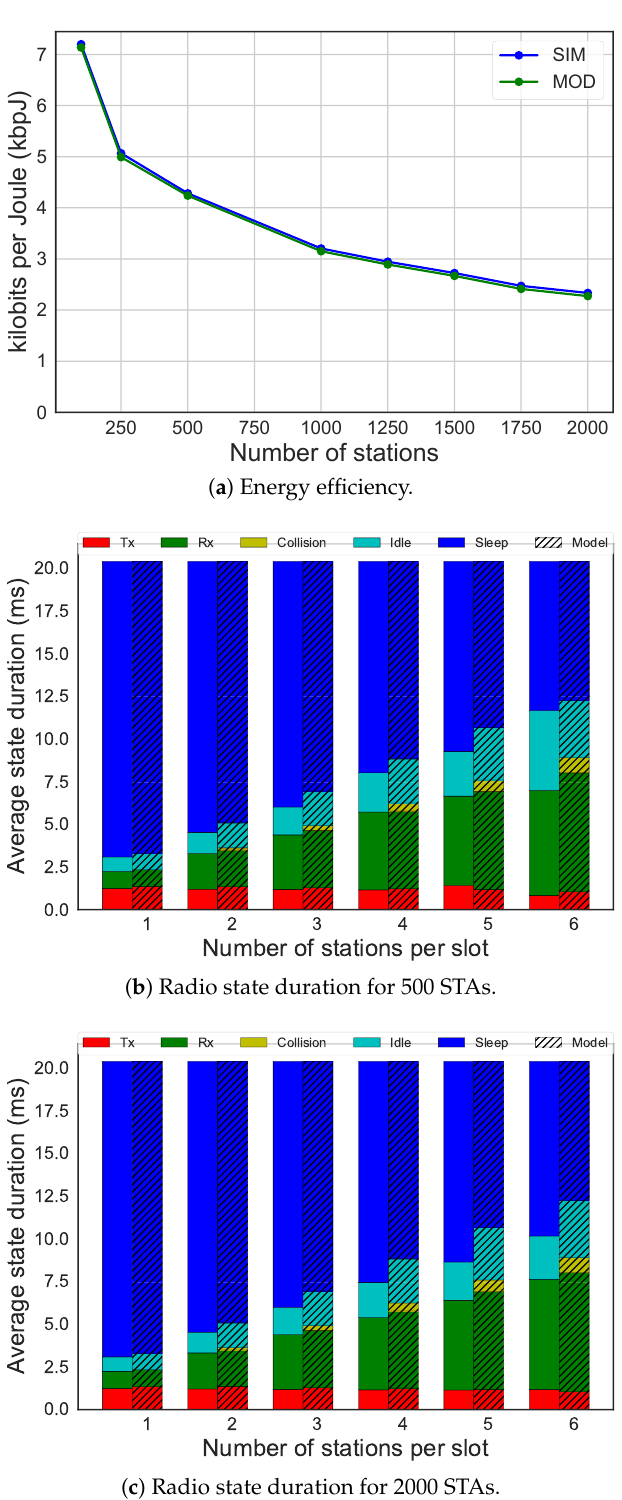
Figure 7. Comparison of results between SIM and analytical MOD for 600 kbps, 16 bytes payload size, 60 s packet arrival interval, 10 groups, and five slots per